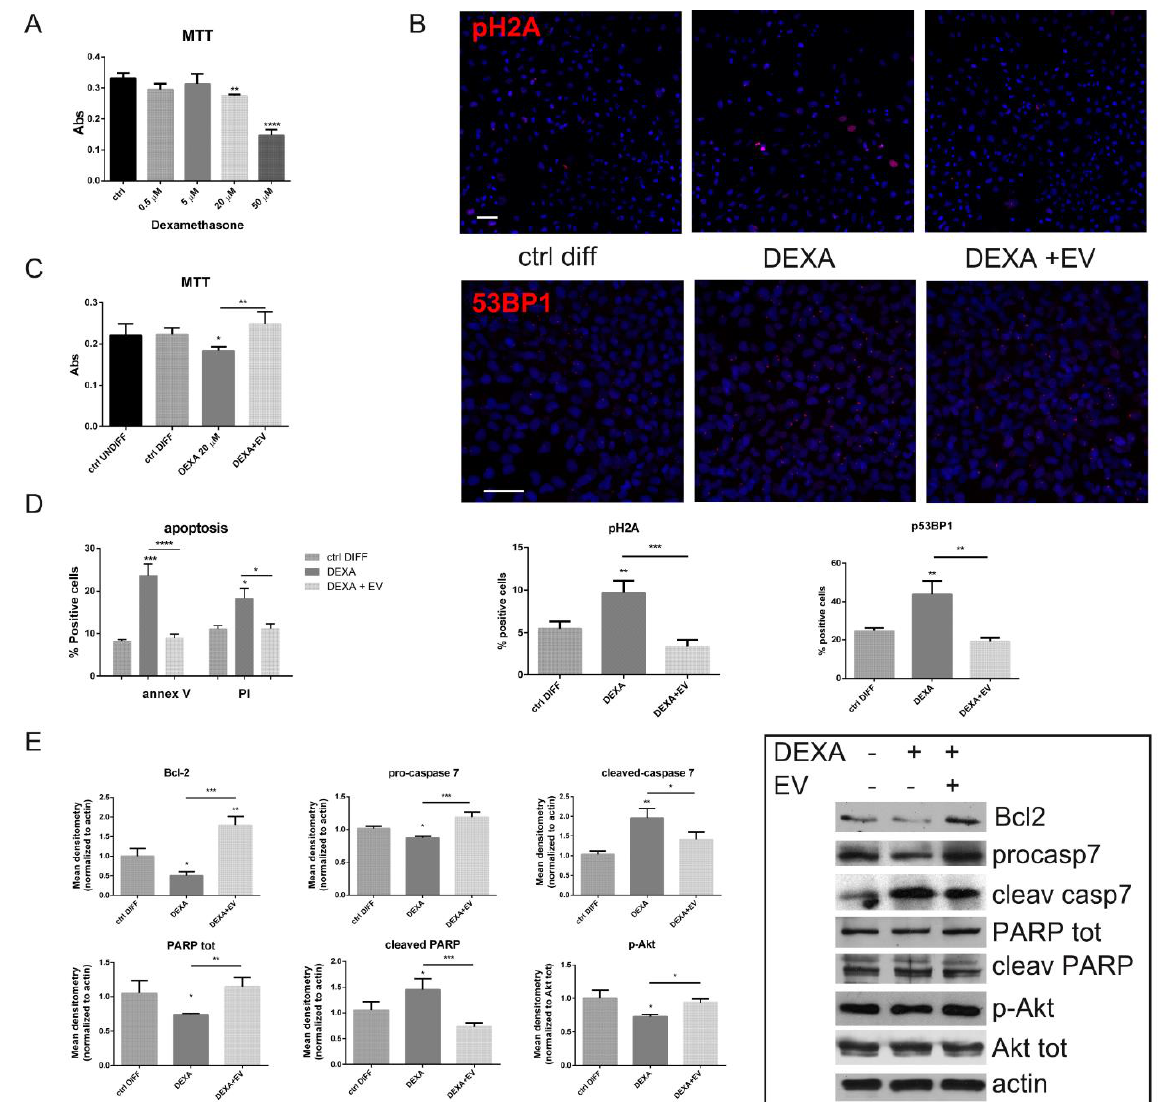
Figure 1. Effect of extracellular vesicles secreted by human amniotic fluid stem cells (AFSC-EV) supplementation on cell both viability and apoptotic pathway of human pre-osteoblast cells (HOB) treated or not with Dexamethasone. ( A )—Graph showing MTT assay of HOB cells treated with increasing concentrations of dexamethasone (DEXA). ** p value < 0.01; **** p value < 0.0001. ( B )—Representative images with 4’,6-diamidino-2-phenylindole (DAPI) (blue) and pH2A (red) or 53BP1 (red) signals of HOB cells incubated or not with DEXA and extracellular vesicles (EV) are shown. Scale bar = 25 µ m. Percentage of positive cells visualized in 5 fields for each condition are shown in the graphs below. ** p value < 0.01; *** p value < 0.001. ( C )—Graph showing MTT assay of HOB cells pre-treated with EV and then exposed to 20 µ M DEXA. * p value < 0.05; ** p value < 0.01. ( D )—Graph showing the percentage of positive cells to Annexin V/Propidium Iodide assay, as described in the M&M section. * p value < 0.05; *** p value < 0.001; **** p value < 0.0001. ( E )—WB analysis of total lysate of HOB cells treated or not with AFSC-EV in the presence of DEXA, then revealed with anti-Bcl-2, anti-caspase 7, to detect the procaspase and the cleaved form, anti-PARP, to detect PARP total and its cleaved form, anti-pSer473Akt, and anti-Akt total antibodies. The graphs represent the mean ± SD of densitometric analysis of three experiments, normalized to actin values. * p value < 0.05; ** p value < 0.01; *** p value <